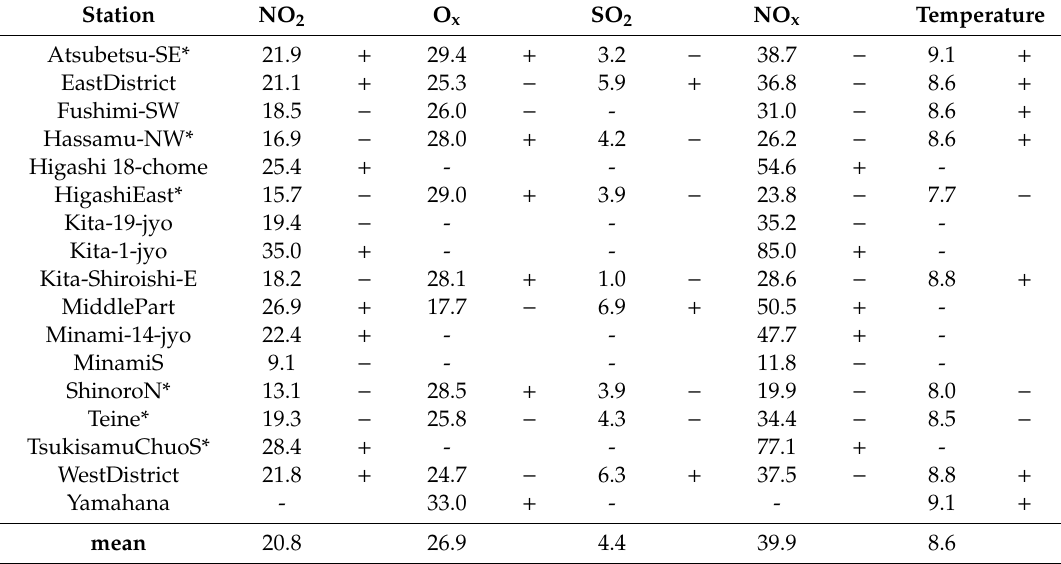
Table 1. Environmental pollution (nitrogen dioxide: NO 2 ; oxides: O X ; sulfur dioxide: SO 2 ; and nitrous gases: NO X ) and climate data of several weather stations across Sapporo, Japan from 1983 to 2012, and variance from the mean value ( + higher than mean, – lower than mean). Added * to station name means suburb or closest to a green area (e.g., near an agriculture field, forested park or reserved forests). Station NO 2 O x SO 2 NO x Temperature Atsubetsu-SE* 21.9 29.4 EastDistrict Fushimi-SW 18.5 − 26.0 Hassamu-NW* 16.9 28.0 Higashi 18-chome 25.4 HigashiEast* 15.7 Kita-19-jyo 19.4 35.2 Kita-1-jyo 35.0 Kita-Shiroishi-E 18.2 MiddlePart 26.9 + 17.7 6.9 50.5 - Minami-14-jyo 22.4 47.7 - MinamiS 9.1 − - - 11.8 − - ShinoroN* 13.1 − 28.5 TsukisamuChuoS* Yamahana -